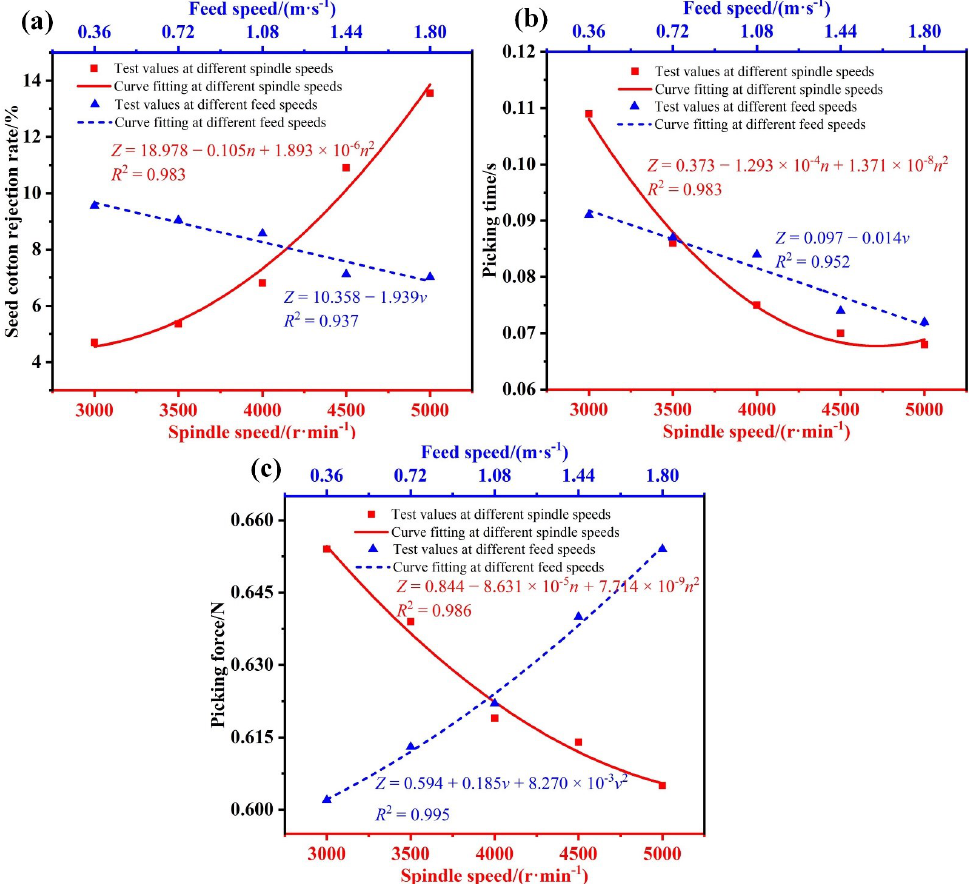
Table 4. Analysis of variance of test results.